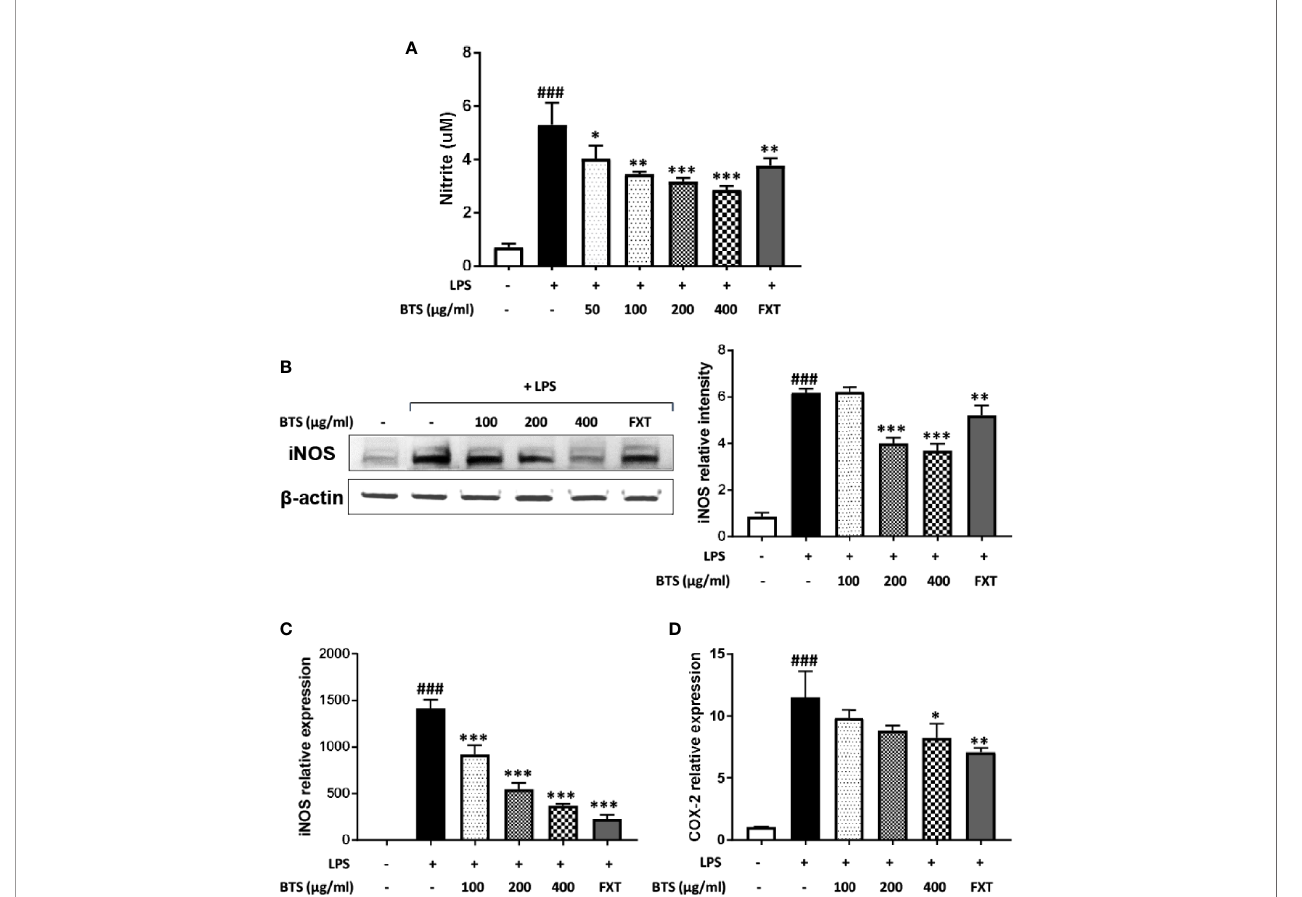
FIGURE 5 | Effect of BTS on NO production and iNOS and COX-2 expression in BV2 cells. BV2 cells were pretreated with BTS for 1 h and then stimulated with LPS (100 ng/ml) for 24 h. (A) The levels of NO in the cell culture supernatant were measured by NO detection kit. (B) The level of iNOS was determined by western blotting. b -actin was used as a loading control. The data represent three independent experiments. BV2 cells were pretreated with BTS for 1 h and then stimulated with LPS (100 ng/ml) for 6 h. Levels of (C) Nos2 and (D) Cox2 mRNAs were determined by real-time PCR. Gapdh was used as a loading control. The data represent the mean ± SD of triplicate determinations (one-way ANOVA: ### p < 0.001 vs. untreated control; *p < 0.05, **p < 0.01, ***p < 0.001 vs. LPS-treated